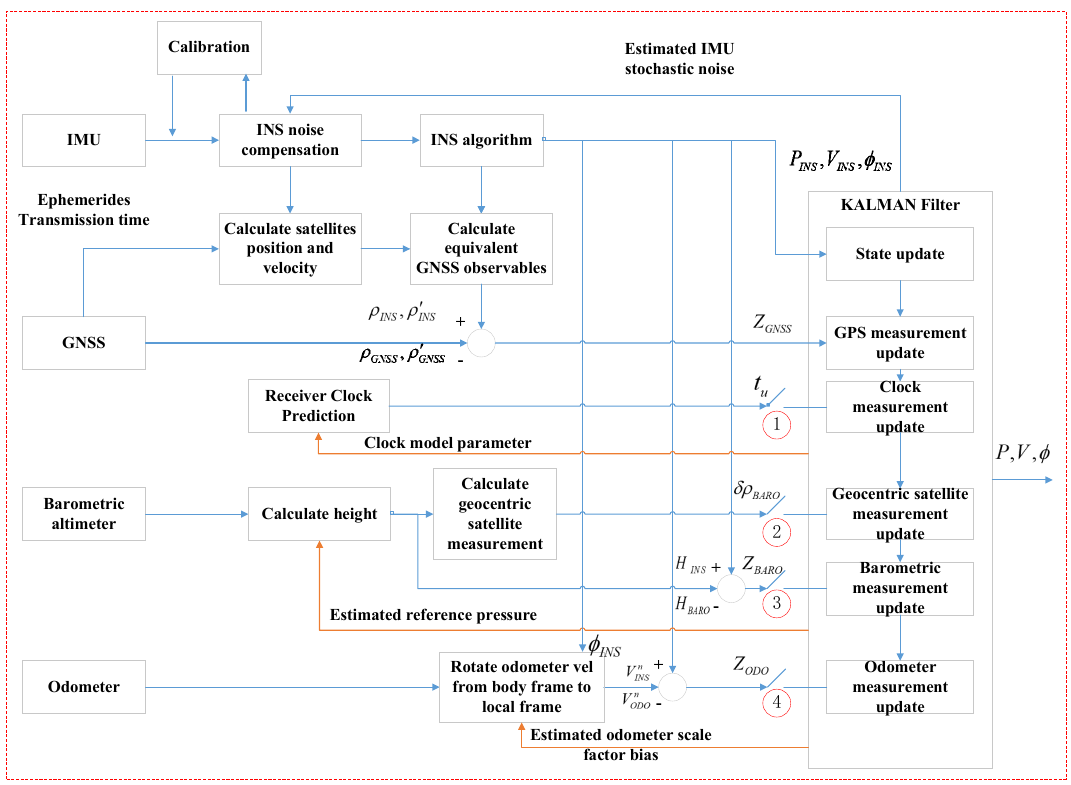
Figure 1. Flow chart of the multi-sensor tight fusion (MTF) method.